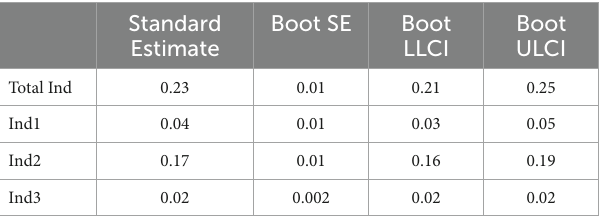
TABLE 5 Mediation effects of self-efficacy,